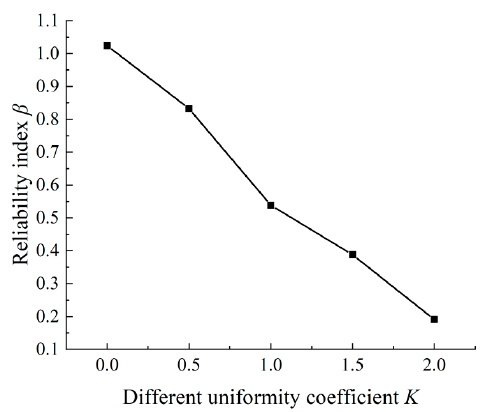
Figure 3. Reliability index of the analysis versus nonuniformity coefficient